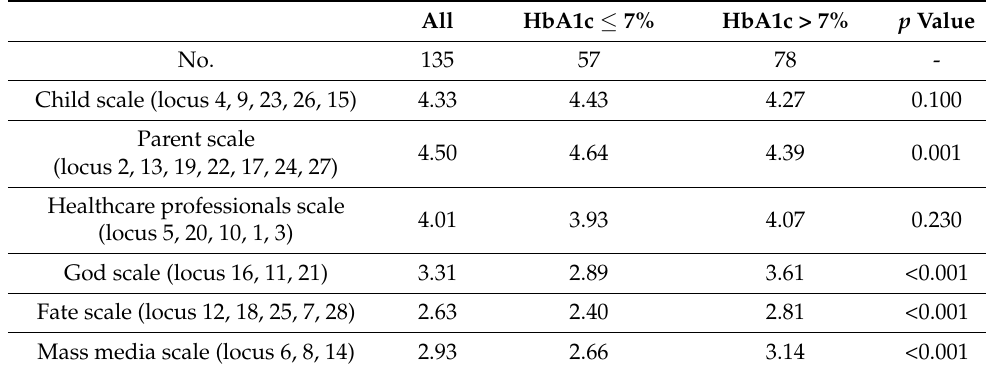
Table 3. Scores at the Parental health locus of control questionnaire, in the two study groups. Mean ± SD. All HbA1c ≤ 7% HbA1c > 7% p Value No.